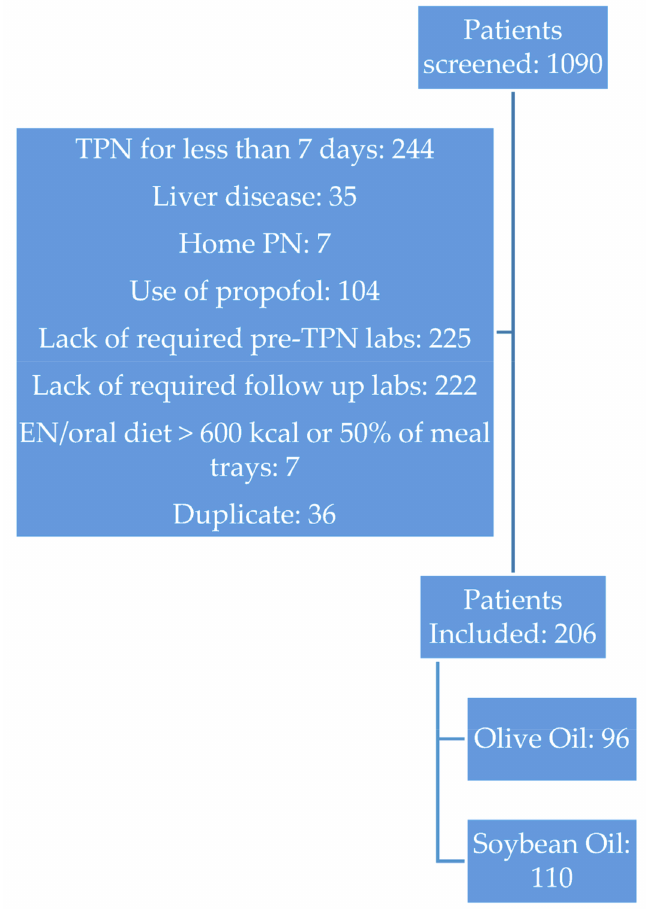
Figure 1. Screening, inclusion and exclusion